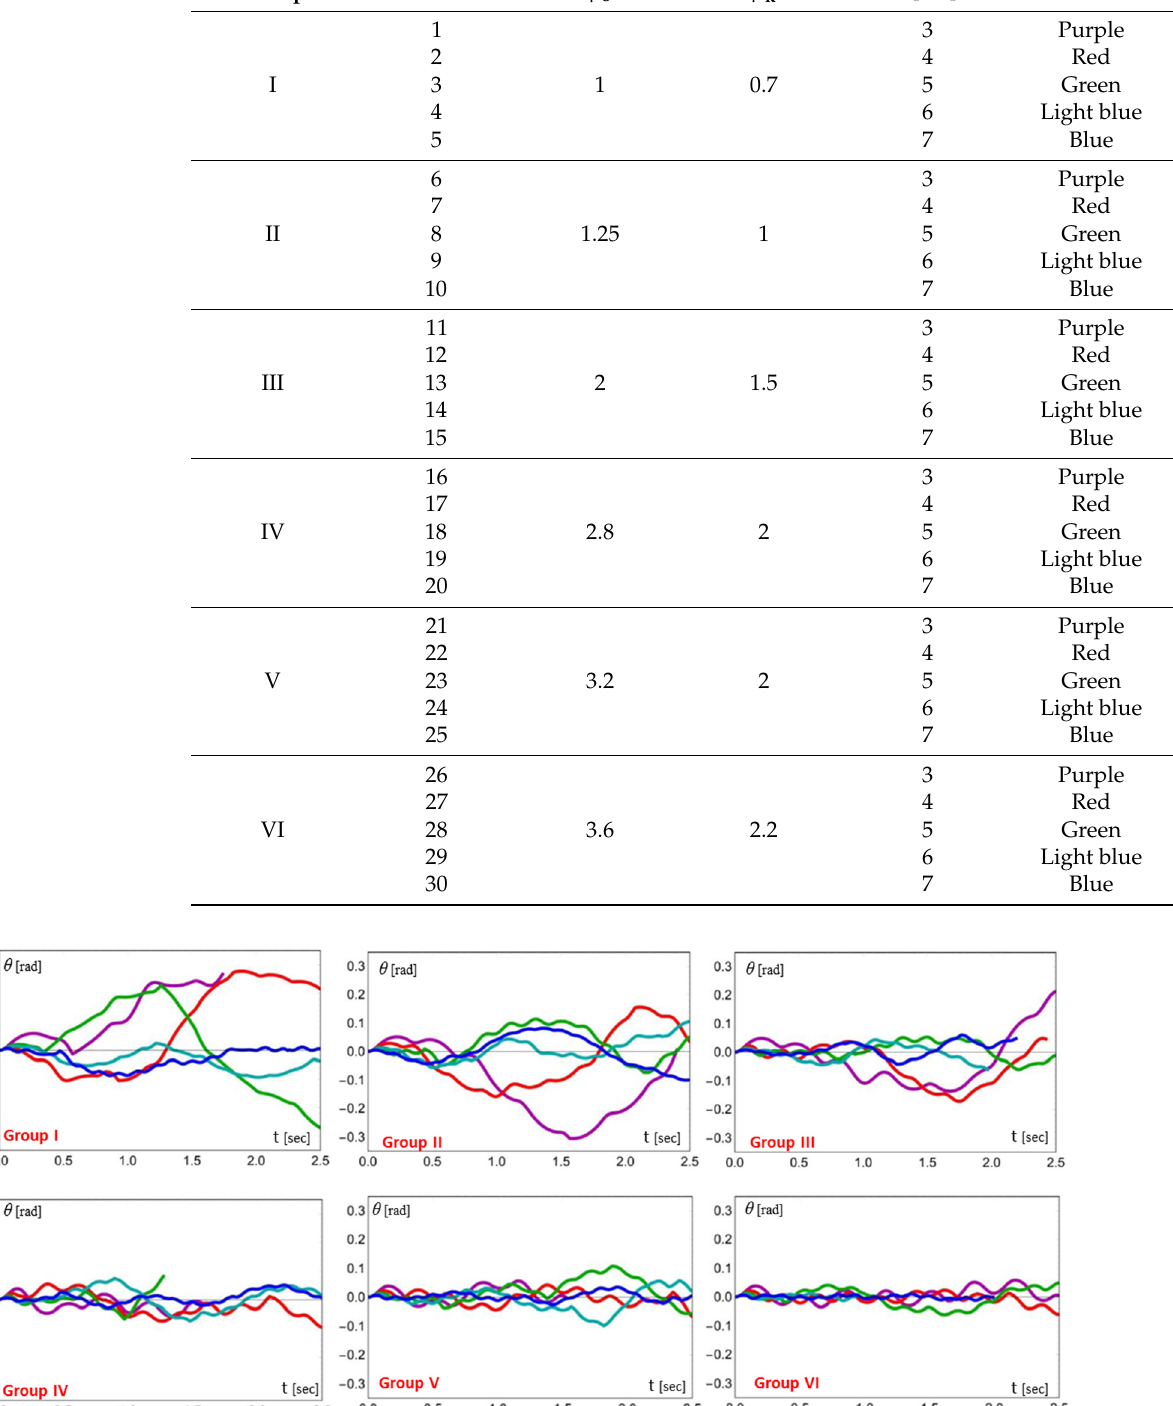
Table 2. Groups of combinations for a = 0.4 g.